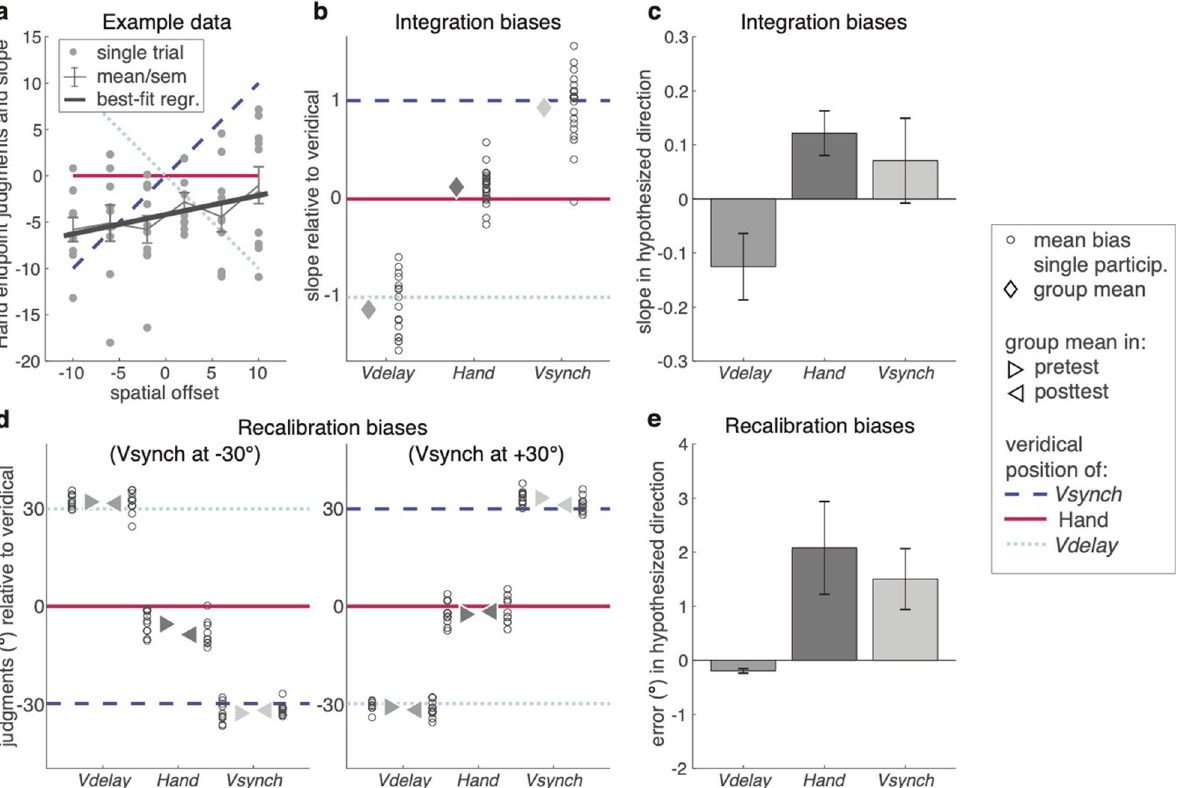
Figure 2. Integration and recalibration biases in experiment 1: In all panels, horizontal solid red lines indicate the veridical hand endpoint, the diagonal broken blue line that of Vsynch , and the diagonal dotted light blue line that of Vdelay . ( a ) Integration biases were derived as slopes of linear regressions. This panel shows an example of judgments of the hand endpoints in bimodal judgment trials. The grey dots mark the judgment errors in individual trials. For this participant, there was a positive slope of .21, indicating that the judgments of hand endpoints were biased towards the position of Vsynch . ( b ) Individual participants’ integration biases relative to the veridical stimulus positions. The small open circles indicate individual participants’ mean slopes; diamonds indicate the group mean. ( c ) The average integration biases (mean ± SEM) in the hypothesized direction: Hand endpoint towards Vsynch , Vsynch and Vdelay towards the hand endpoint. ( d ) Recalibration biases (judgment errors in degrees) for the pre-test and the post-test relative to the veridical positions of the hand, Vsynch , and Vdelay . The results are shown separately for the participants that received Vsynch at − 30° or at + 30° offset. ( e ) The average recalibration biases (mean ± SEM) as differences between post-test and pre-test with the positive sign indicating the expected direction of the bias: hand endpoint towards where Vsynch had been presented in the preceding exposure trials, Vsynch and Vdelay towards where the hand endpoint had been in the preceding exposure